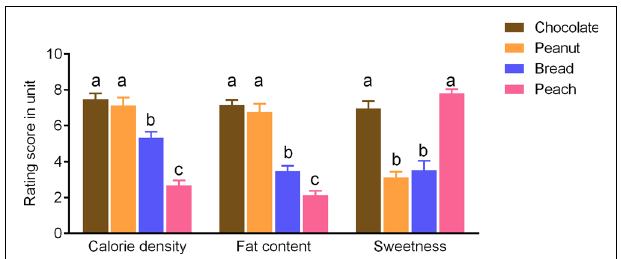
FIGURE 1 | Rating scores of the sweetness levels and estimated fat content or calorie density for food odors). Values are means with error bars (SEM), with different lowercase letters indicate significant differences ( p <